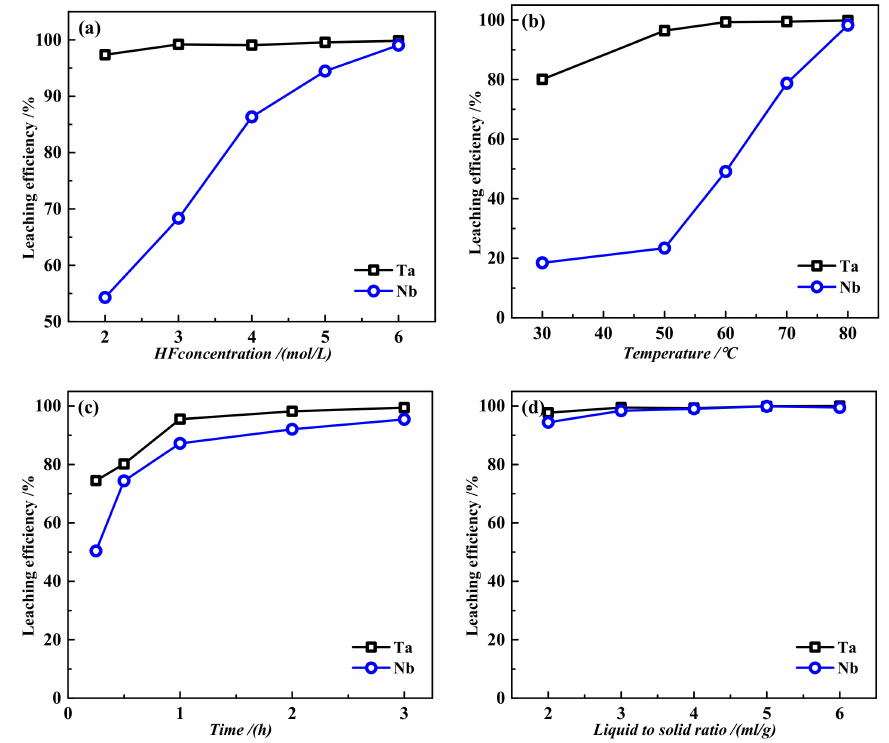
Figure 11. Effect of the different conditions on leaching of alkaline decomposition residue: ( a ) temperature 60 ◦ C, time 1h, liquid–solid ratio 4mL/g; ( b ) HF 5 mol/L, time 1h, liquid–solid ratio 4mL/g; ( c ) HF 5 mol/L, temperature 70 ◦ C, liquid–solid ratio 4mL/g; ( d ) HF 5 mol/L, tempera- ture 70 ◦ C, time